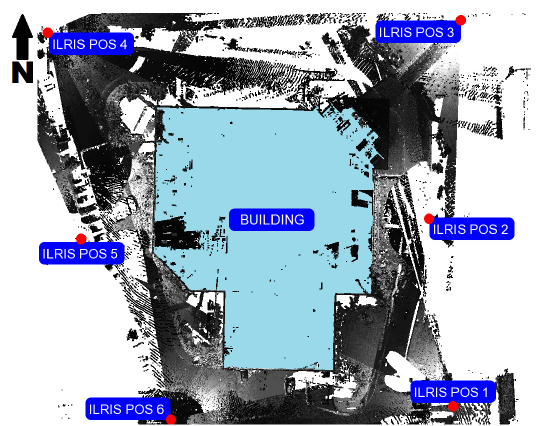
Figure 2. ILRIS-LR scanner positions used to scan the Teledyne-Optech building.